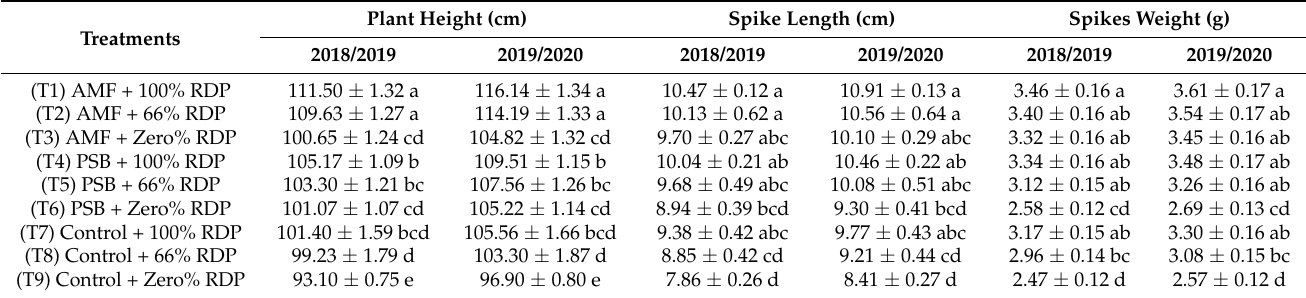
Table 3. Plant height, spike length, and spikes weight of Giza 123 barley cultivar were influenced by the treatment with arbuscular mycorrhizal fungi (AMF), phosphate-solubilizing bacteria (PSB), and different percentages of the recommended dose of phosphorus fertilizers (RDP) in the 2018/2019 and